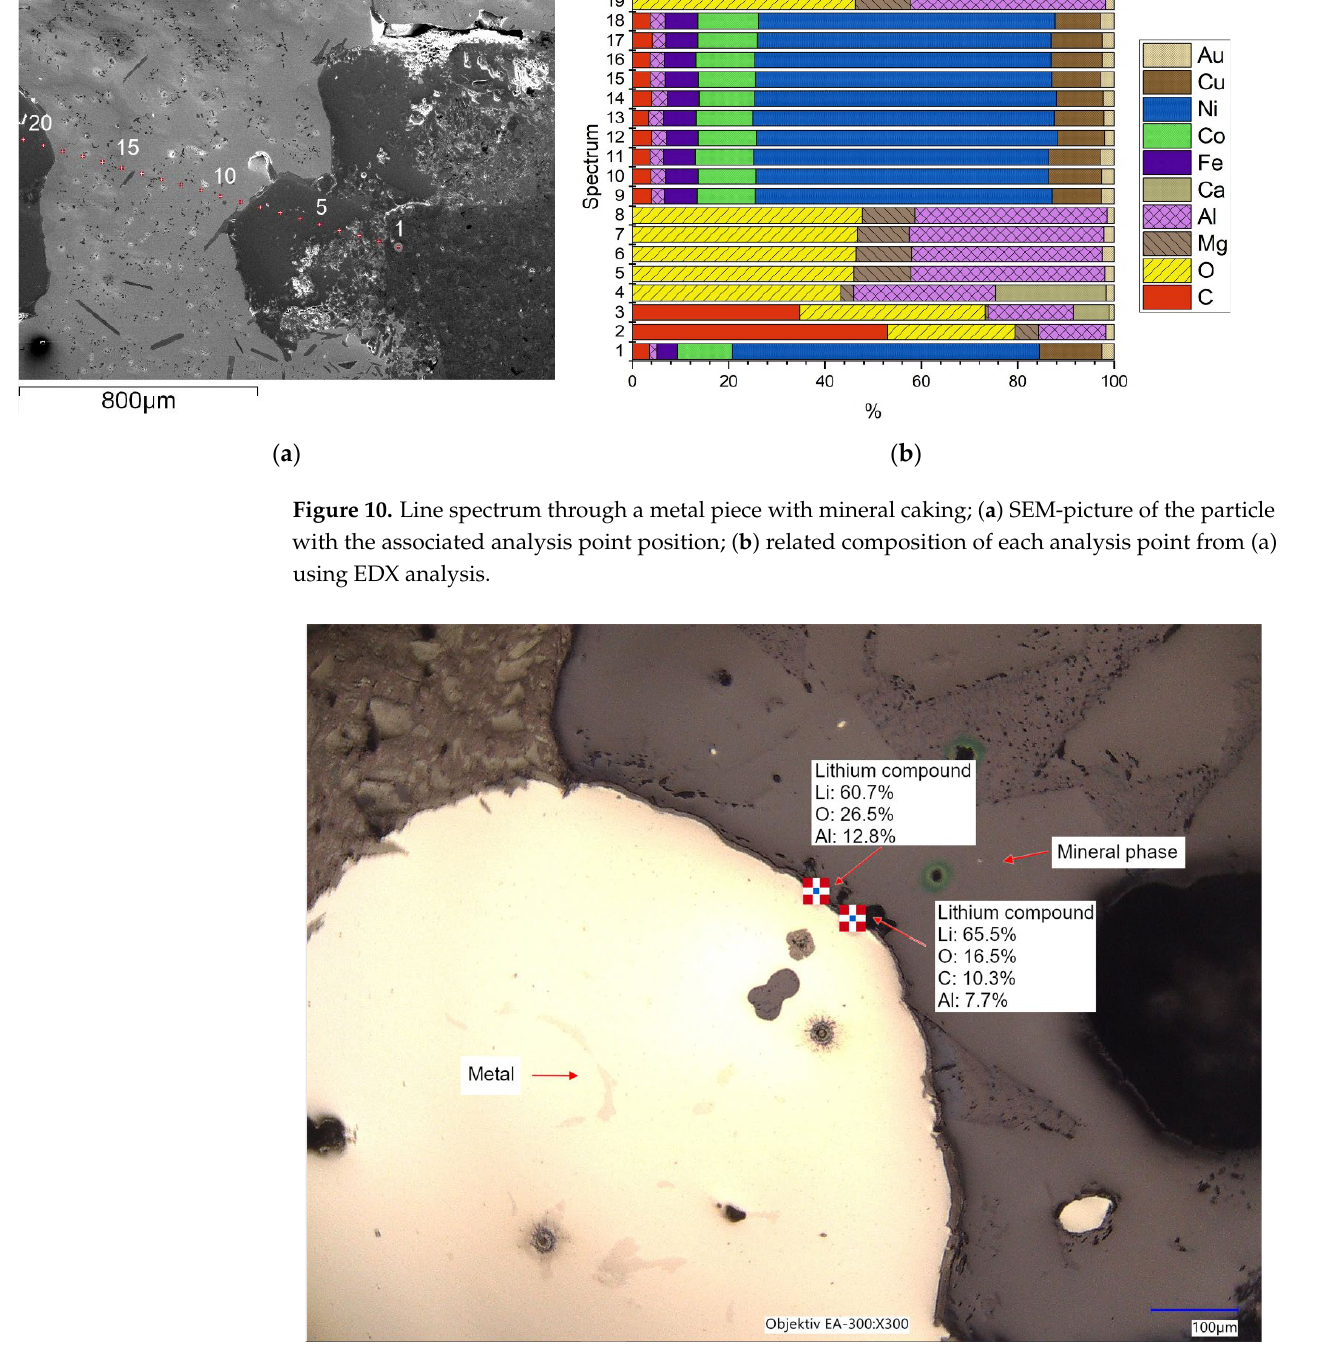
Figure 11. Digital microscopic image of the interface between metal and mineral phase with corre- sponding LIBS measurements.